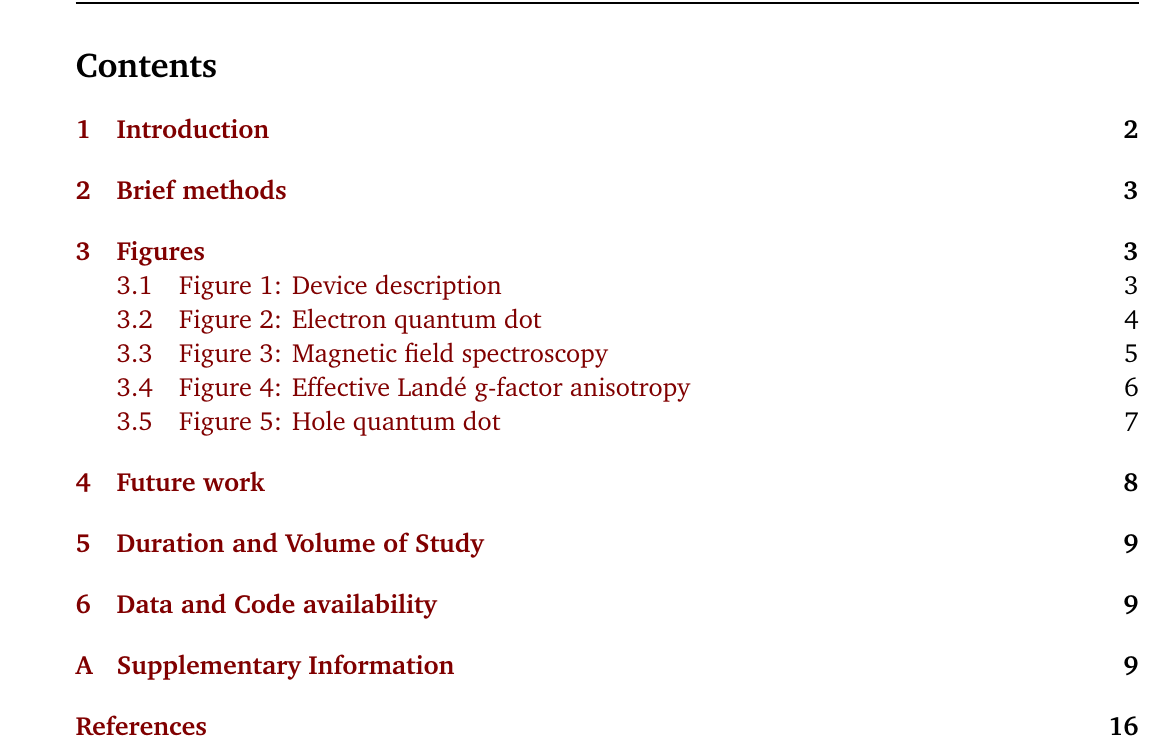
Figure 1: Device description Figure 2: Electron quantum dot Figure 3: Magnetic field spectroscopy Figure 4: Effective Landé g-factor anisotropy Figure 5: Hole quantum